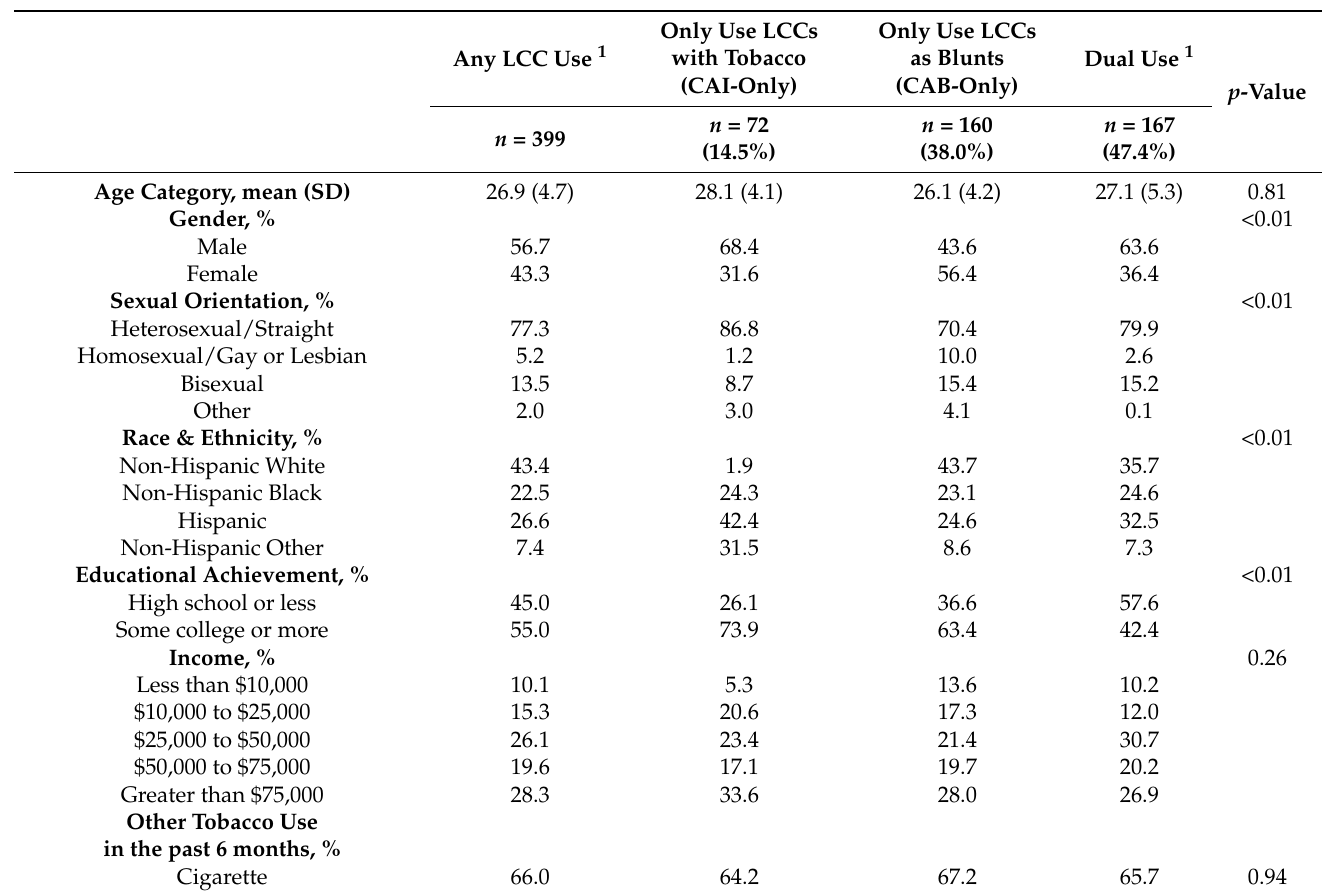
Table 1. Demographic characteristics of past 6 month LCC users by use